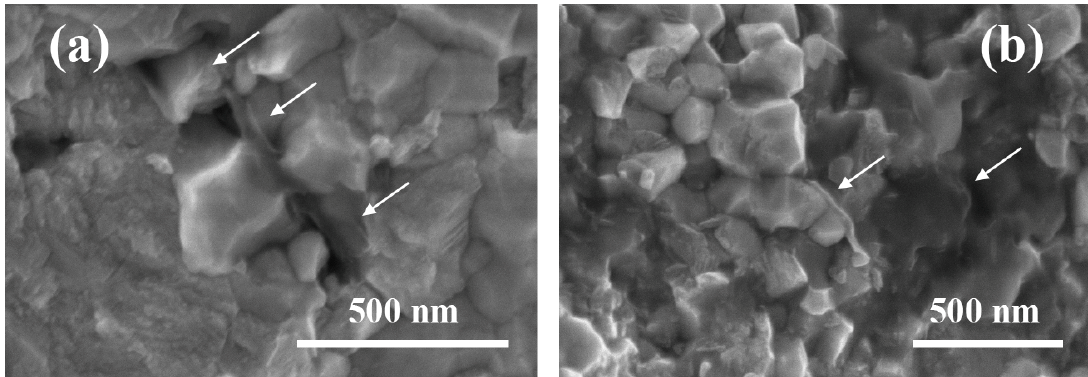
Figure 6. HRSEM micrographs of the fracture surface of the sintered composite. ( a ) Some GNS can be seen as semi-transparent tissue; ( b ) some GNS can be seen from a side view.